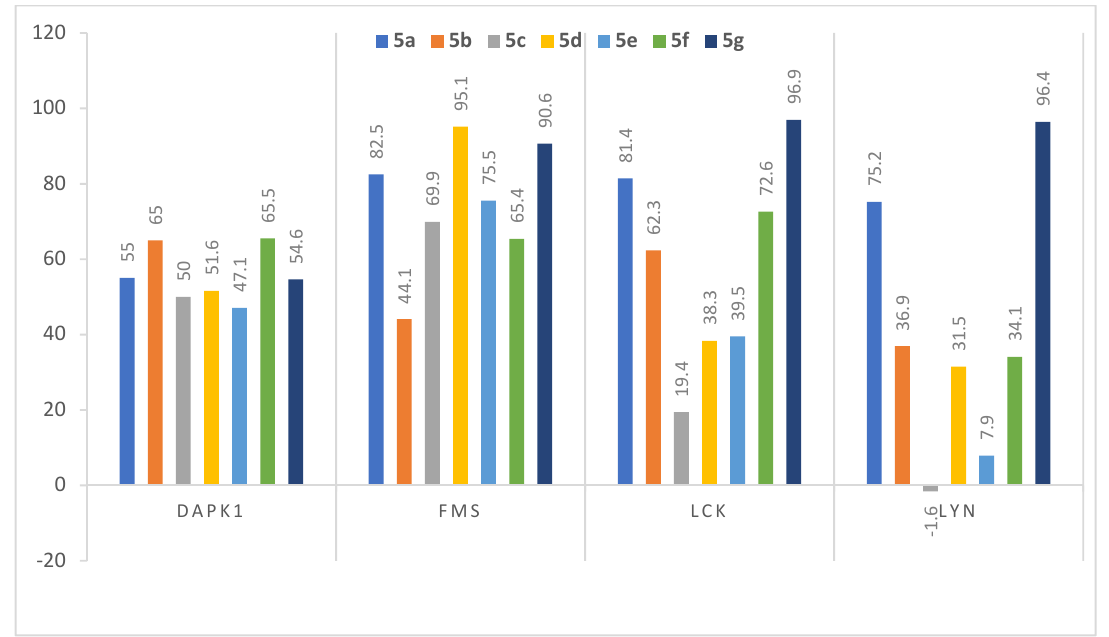
Figure 2. Schematic chart for percent enzyme inhibition (relative to DMSO controls) of all synthesized analogs at a concentration of 10 µM over DAPK1, FMS, LCK, and LYN kinases.